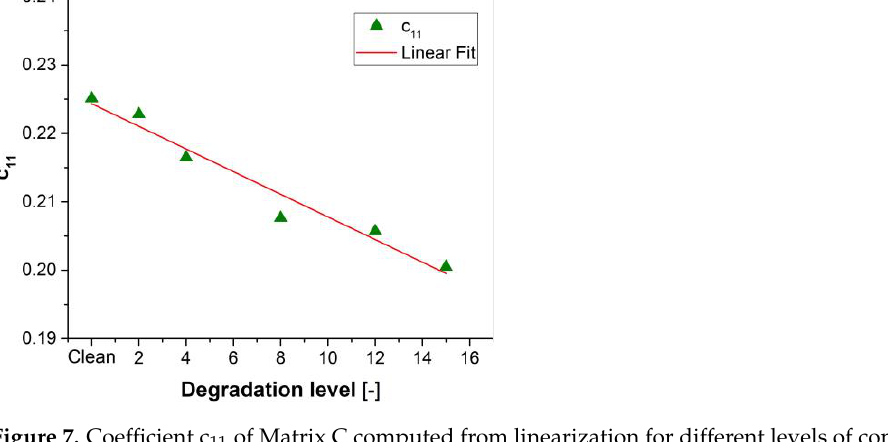
Figure 7. Coefficient c 11 of Matrix C computed from linearization for different levels of compressor degradation (dots) and the linear fit curve.